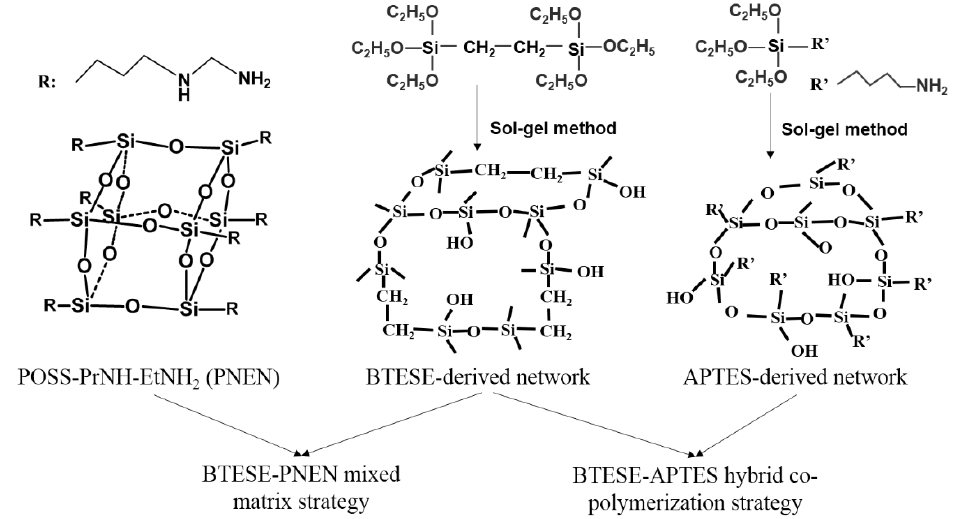
Figure 1. The schematic networks of 1,2-bis(triethoxysilyl)ethane (BTESE)-(–(CH 2 ) 3 –NH–(CH 2 ) 2 –NH 2 )(PNEN) and BTESE-3-aminopropyltriethoxysilane (APTES) hybrid sols.